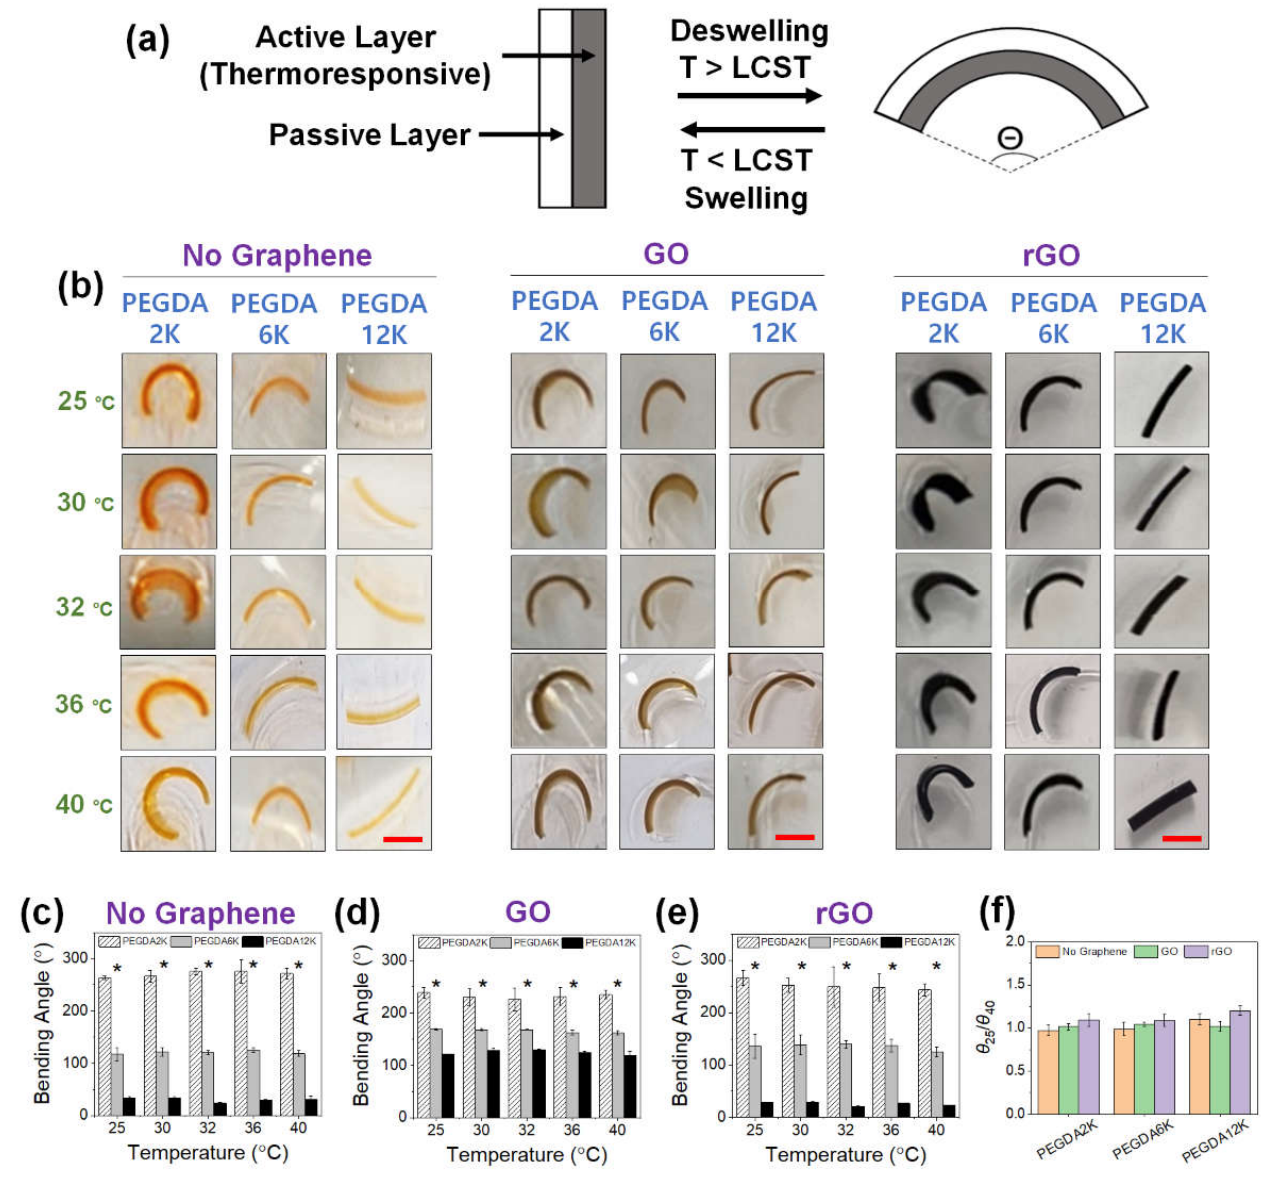
Figure 6. ( a ) Schematic illustration of a thermoresponsive hydrogel bilayer actuator. ( b ) Photographs of GO or rGO-laden PEG hydrogel actuators, without PNIPAm, at various temperatures from 25 ◦ C to 40 ◦ C (scale bar: 5 mm). The concentration of GO or rGO was 0.2%. For PEGDA hydrogels without graphene, orange dye was added for better visualization. ( c – e ) The bending angles were quantified from the images in ( b ) (* p < 0.05 compared between different M W ’s of PEGDA, n = 10). ( f ) The ratios of bending angles measured at 25 ◦ C ( θ 25 ) and 40 ◦ C ( θ 40 ).